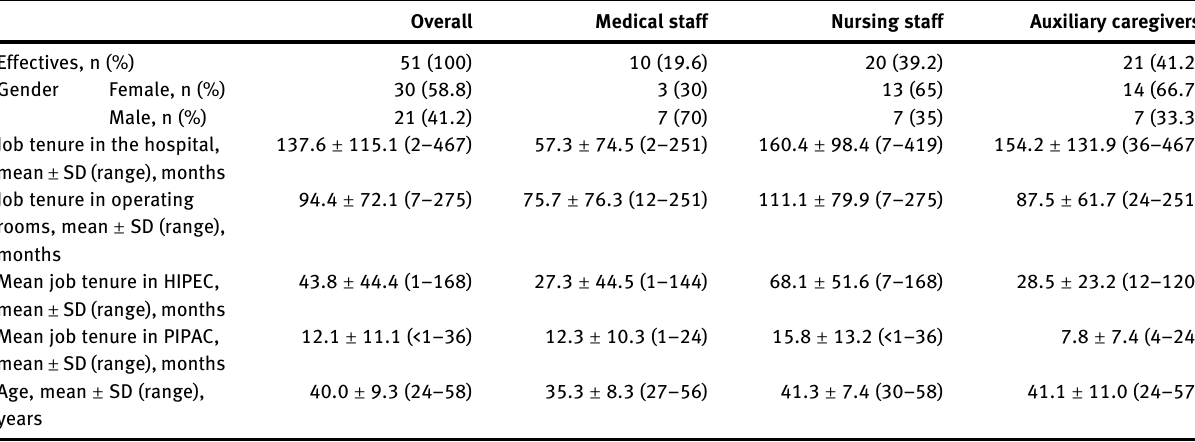
Table  A: Participants ’